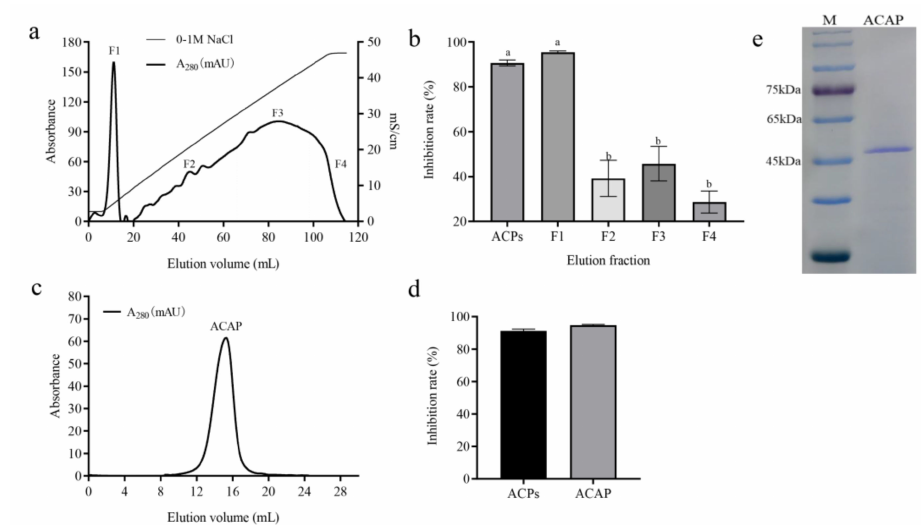
Figure 2. Purification and in vitro antitumor activities of ACPs: ( a ) Anion exchange chromatog- raphy; ( b ) in vitro antitumor activities of various fractions (F1–F4: fractions 1–4); ( c ) gel filtration chromatography; ( d ) in vitro antitumor activities of ACPs and ACAP; ( e ) SDS-PAGE assay of ACAP (M: Standard markers). The concentration of each fraction in ( b , d ) was 50 µ g/mL. Differing letters above bars indicate significant ( p < 0.05) differences according to Tukey’s multiple comparisons test.